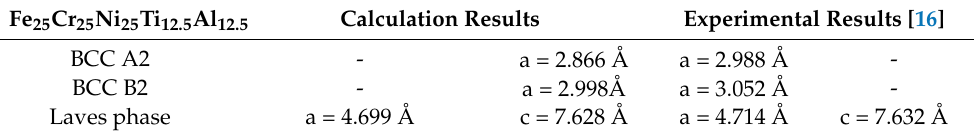
Figure 11. The supercells of the disordered BCC A2 structure ( a ), the ordered BCC B2 structure ( b ), and the Laves phase structure ( c ) employed in the first-principles calculations for Fe 25 Cr 25 Ni 25 Ti 12.5 Al 12.5 multi-principle element alloys. Table 2. Shows the lattice parameters of the supercells calculated by the direct optimization method for the Fe 25 Cr 25 Ni 25 Ti 12.5 Al 12.5 alloy.